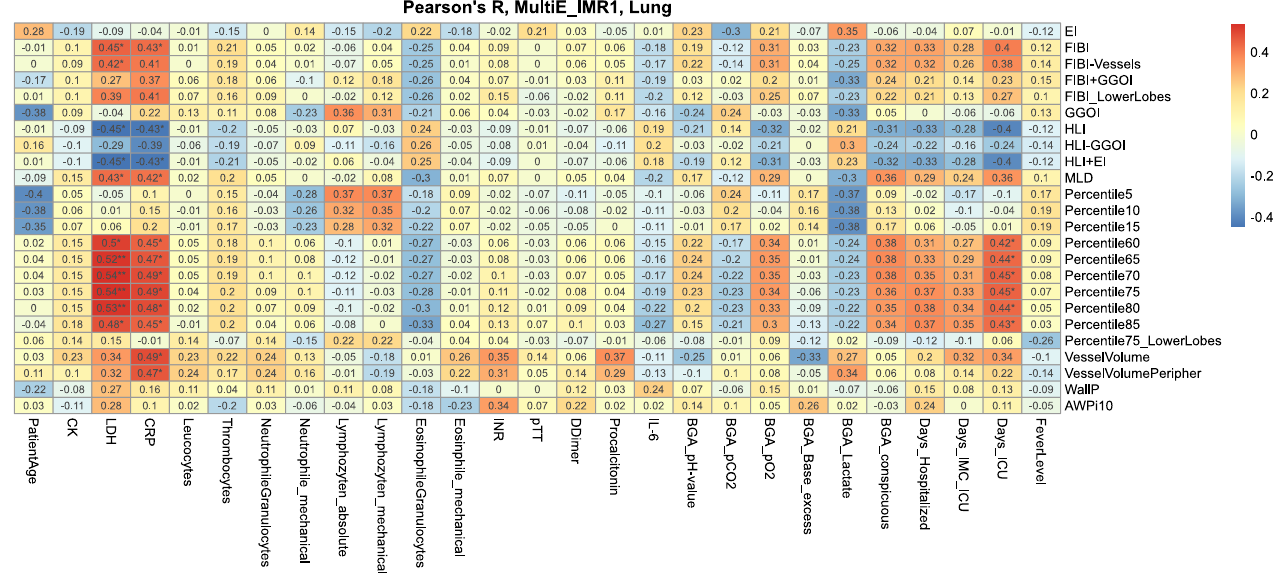
Fig 2. Heat map of Pearson’s correlation between QCT lung segmentation (y-axis) and laboratory parameters and clinical outcome (x-axis). Significant codes: ��� p < 0.001 / �� p < 0.01 / � p < 0.05.